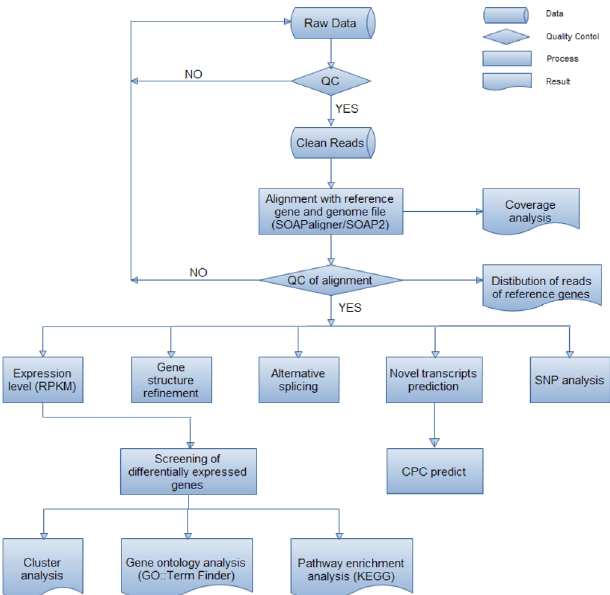
Fig 1. Four representative samples of grapevine leaf (1A, 2A.3A and